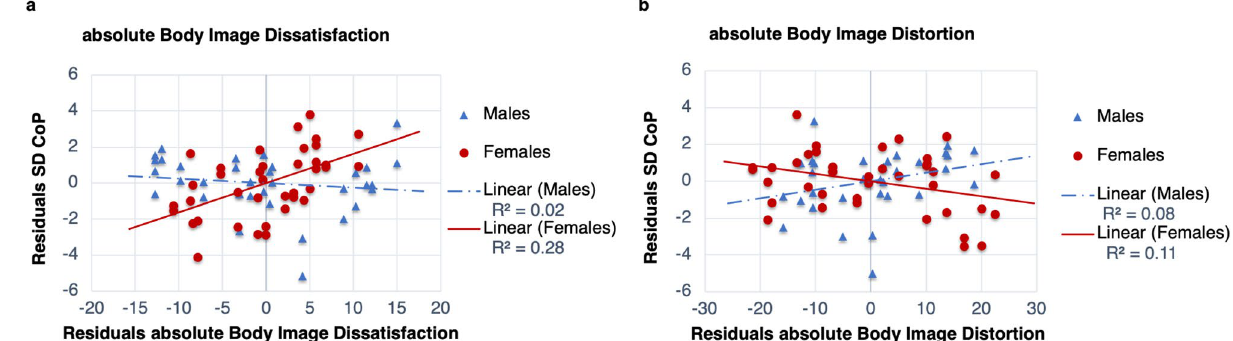
Figure 2. Gender-interactions: partial regression plots of absolute body image dissatisfaction ( a ) and absolute body image distortion ( b